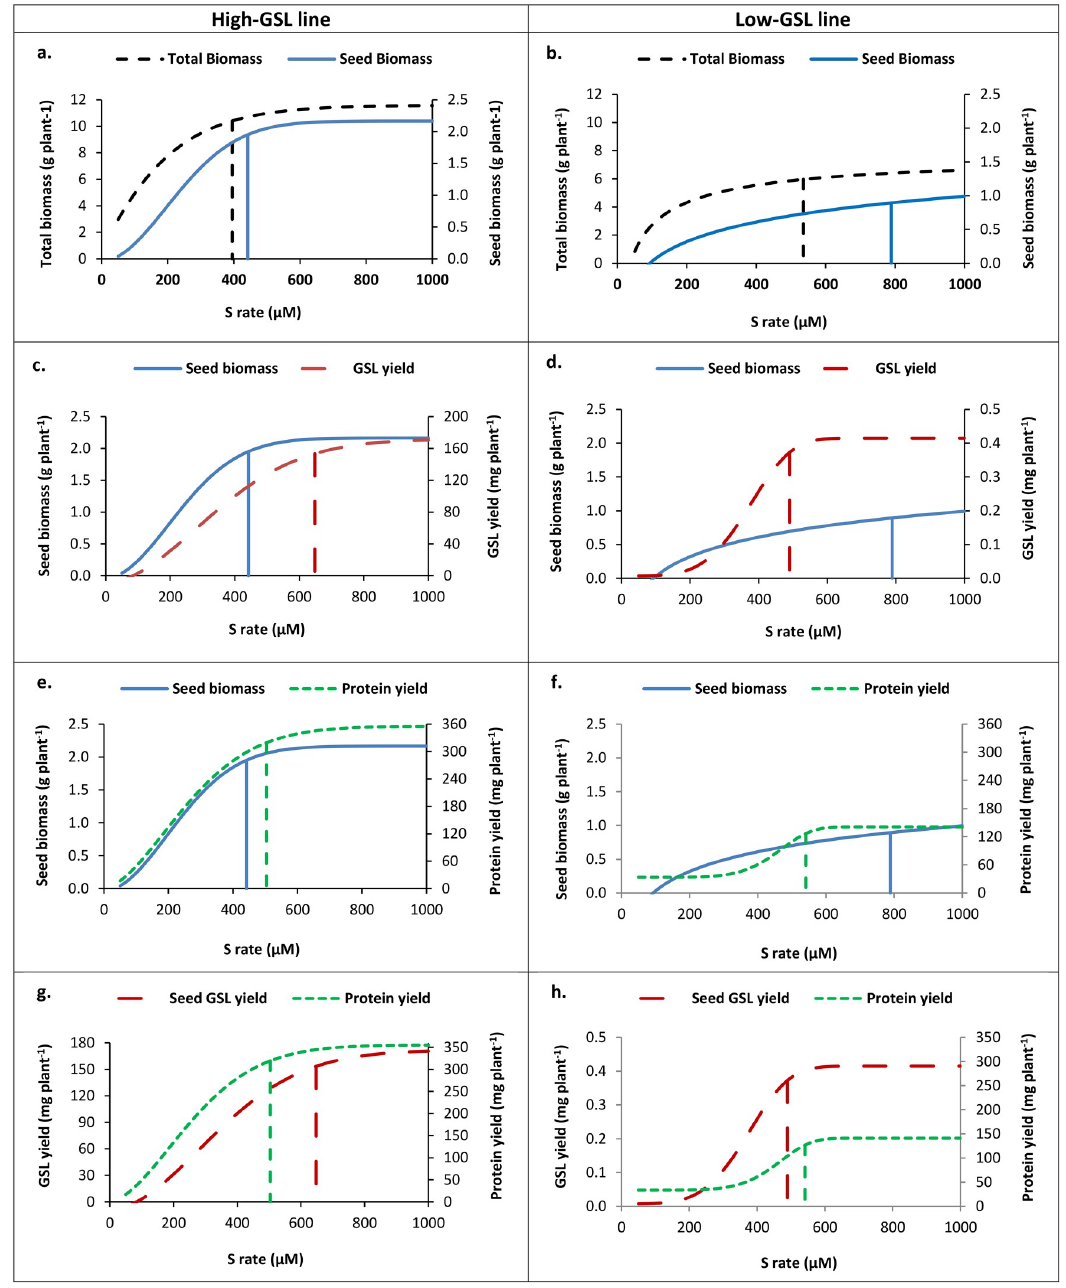
Fig 1. Fitted sulfur response curves using a modified Mitscherlich function with average trait data (S1 Table). Seed and total biomass yield in high- (a) and low-GSL (b) lines, seed yield and seed GSL yield in high- (c) and low-GSL (d) lines, seed yield and seed protein yield in high- (e) and low-GSL (f) lines and seed GSL and seed protein yield in high- (g) and low-GSL (h) lines. Vertical lines indicate applied S level required for 90% predicted maximum respective seed biomass, total biomass, seed GSL and protein yield. Total biomass and seed biomass yield (a-f) are expressed as g plant -1 . Seed GSL and seed protein yield (c-h) are expressed as mg plant -1 .